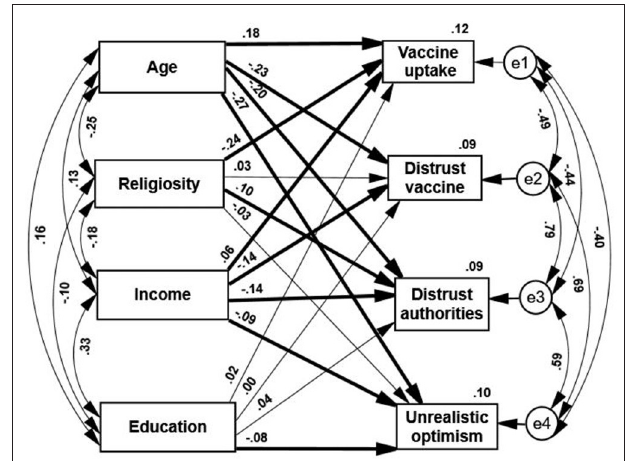
FIGURE 1 | Standardized estimates of path analyses of demographic characteristics predicting vaccine hesitancy and uptake. Thin paths are insignificant. Thick path p <